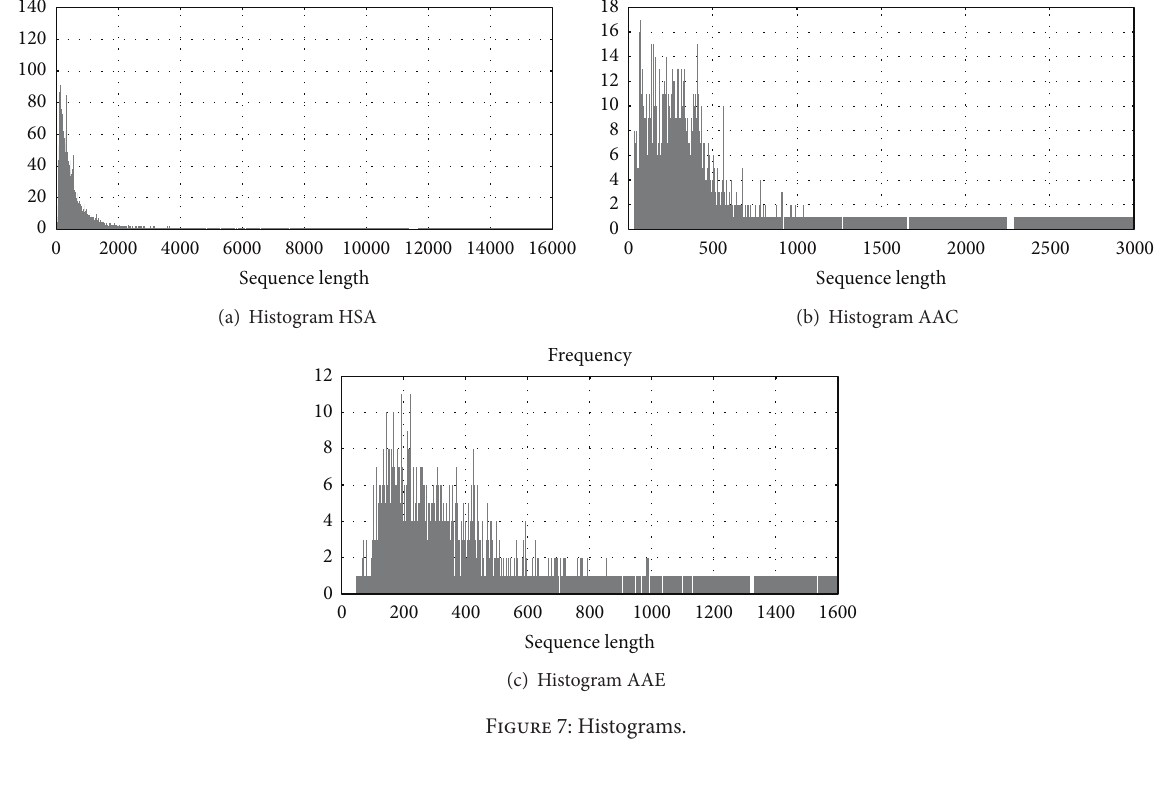
Figure 7: Histograms.